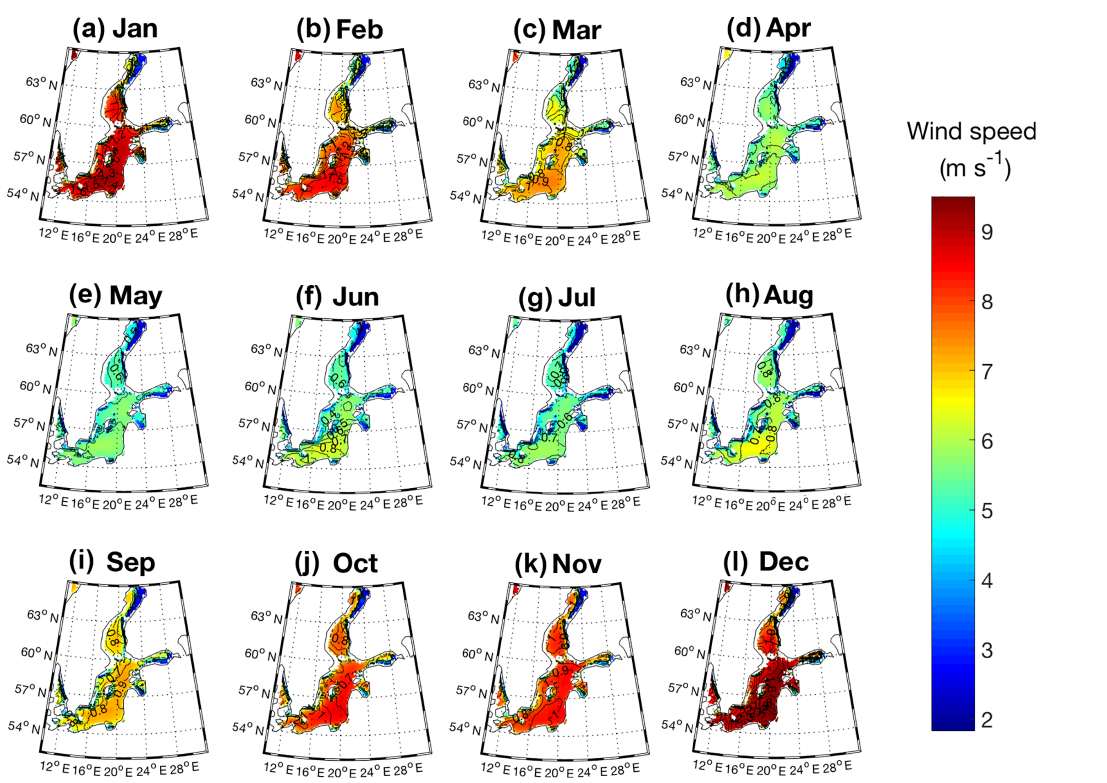
Figure 2. Monthly mean wind speed (indicated by the colour bar) and annual variability (indicated by contours).